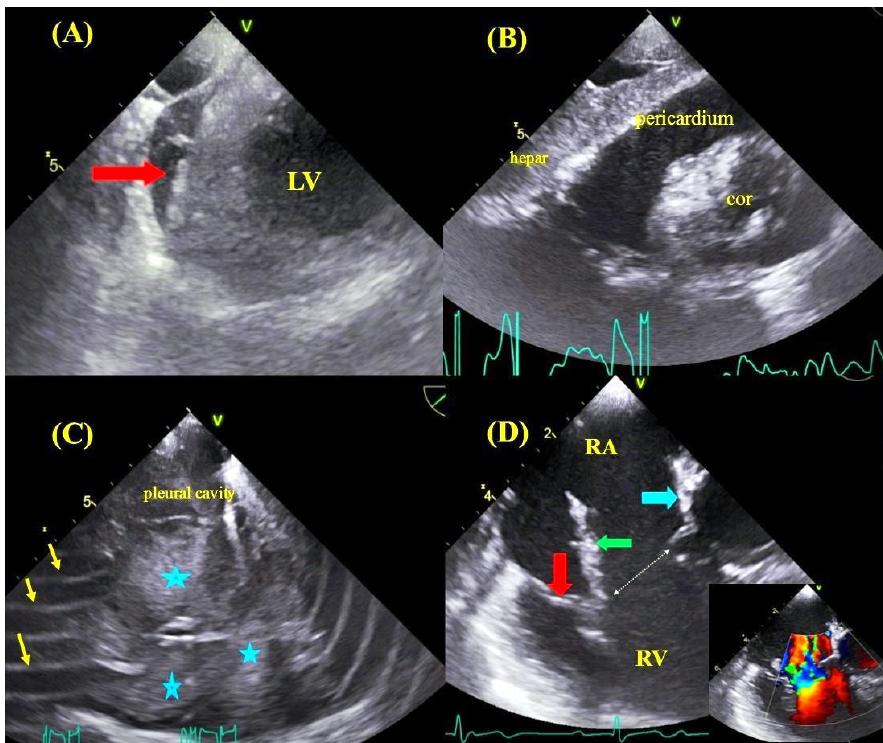
Figure 2. Possible TLE complications detected in TEE: TEE images—transgastric views, the formation of blood clot (red arrow) in the course of self-limiting bleeding into the pericardial sac ( A ), massive bleeding into the pericardial sac resulting in cardiac tamponade ( B ). TEE images—bleeding into the right pleural cavity with visible blood clots (asterisks), image blurring caused by electrocoagulation during thoracotomy (arrows) ( C ). TEE images—low esophageal view—injury to the tricuspid leaflets and papillary muscle rupture resulting in massive tricuspid regurgitation (color Doppler): anterior leaflet (red arrow), ruptured head of the papillary muscle (green arrow), fragment of the septal leaflet (blue arrow) ( D ).